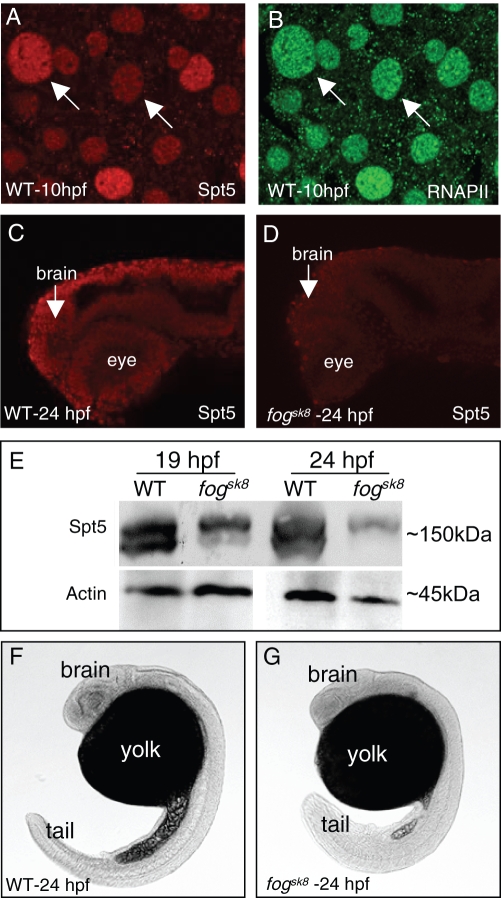
Spt5 protein is significantly decreased in fogsk8 embryos.(A–B) Whole mount immunofluorescence detection of Spt5 and RNAPII in zebrafish embryos, showing the nuclear localization pattern of Spt5 protein. (C–D) Whole mount immunofluorescence detection of Spt5 in WT and fogsk8 embryos at 24 hpf, showing overall decrease of Spt5 protein in fogsk8 embryos. Confocal images of lateral views are shown, with the anterior to the left and dorsal up. (E) Western blot of wild-type (WT) and fogsk8 embryonic extracts at 19 hpf and 24 hpf shows substantial decrease in maternal Spt5 protein in the mutant. (F–G) Light microscopic view of WT and sk8 embryos at 24 hpf, showing the gross morphological phenotype of the mutant embryos.